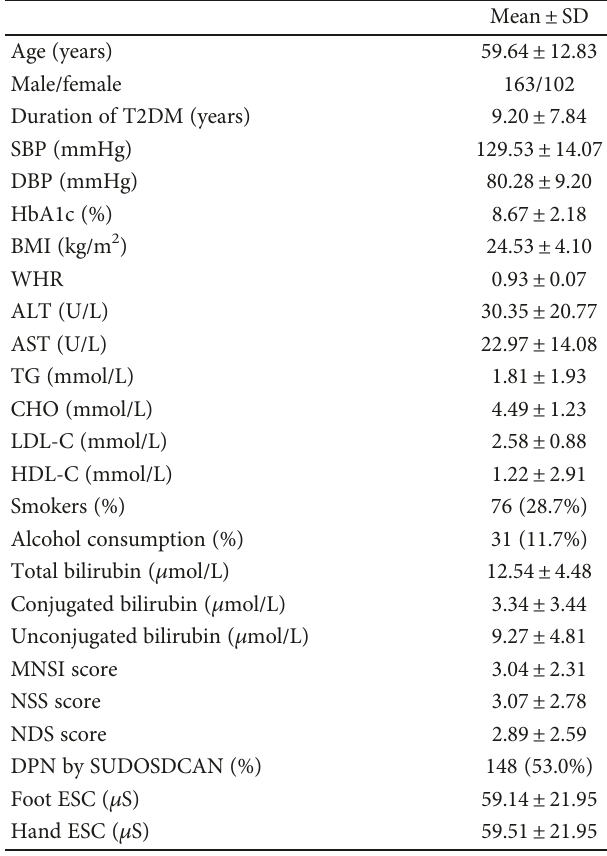
Table 1: Baseline characteristics of 265 T2DM patients enrolled in the